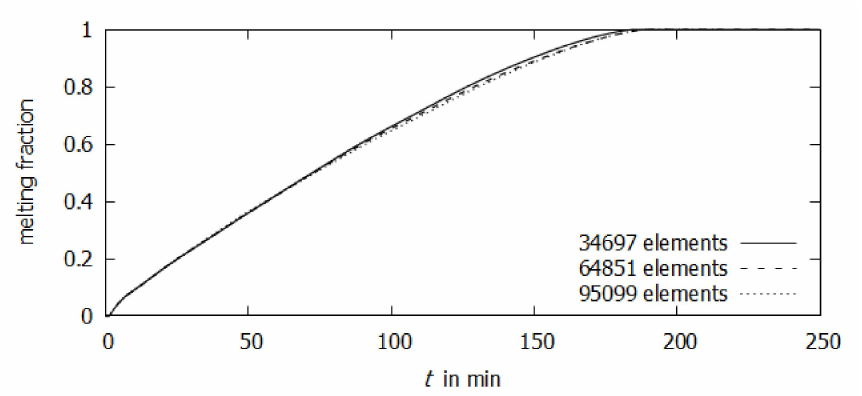
Figure 3. Grid independency